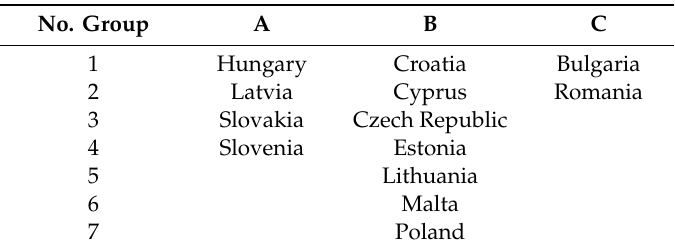
Table 11. Clusters for IREN in 2016.